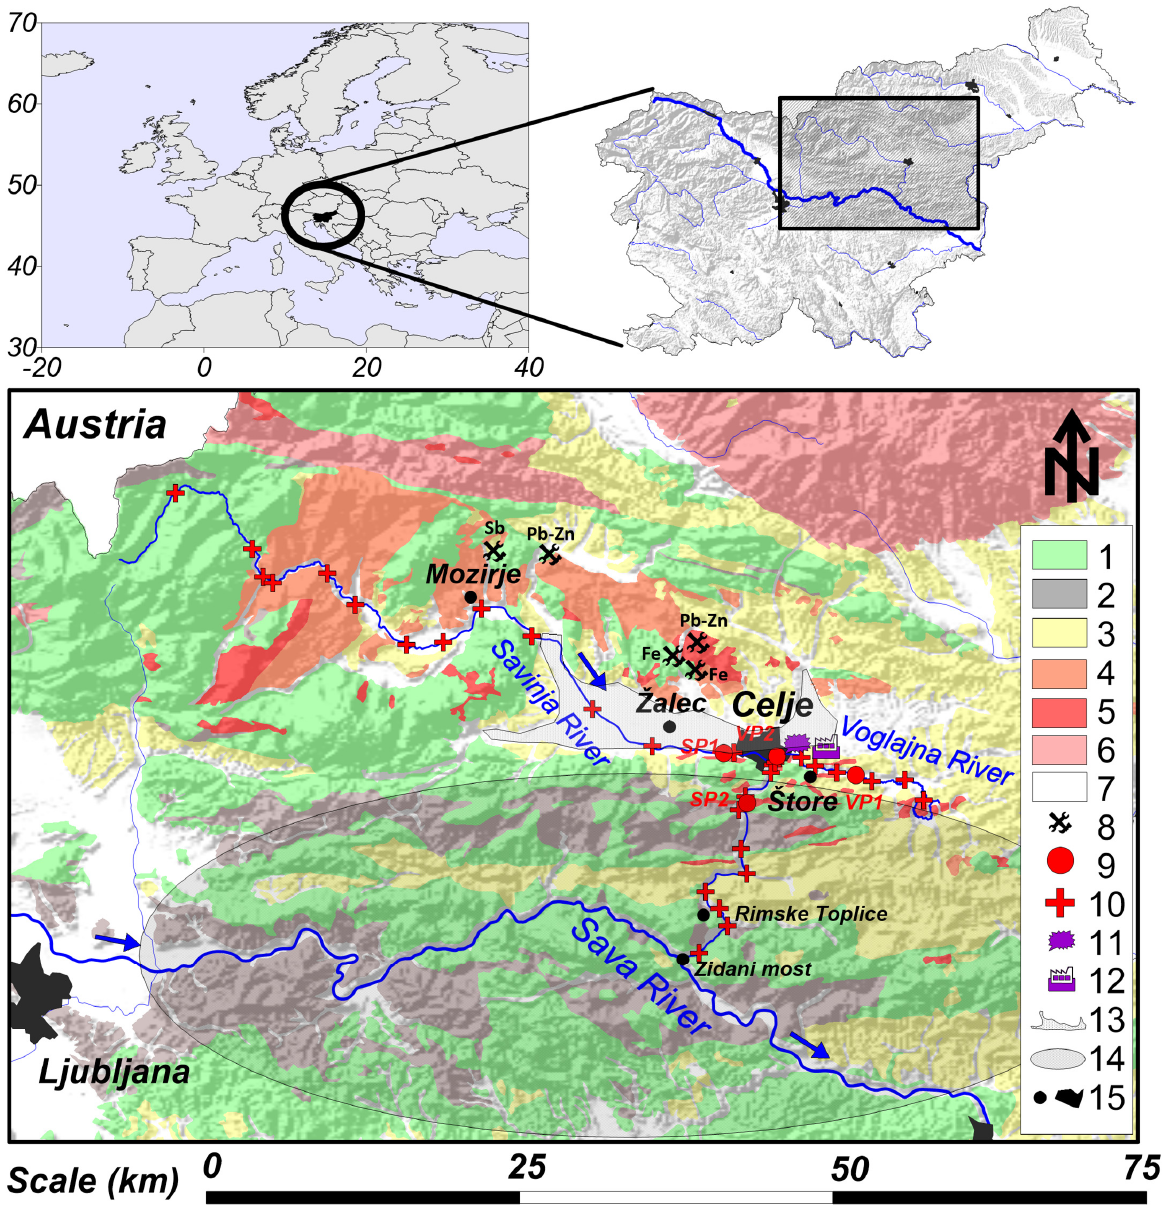
Figure 1. Simplified geological composition of the study area, sampling locations, populated areas, and major anthropogenic sources of elements. 1-mainly Mesozoic carbonates (limestone, dolomite); 2-Palaeozoic clastic rocks; 3-Paleogene and Neogene sedimentary clastic rocks (PG); 4-andesite tuffs and tuffites of Oligocene age; 5-Triassic keratophire intrusions; 6-other volcanic and igneous rocks (mainly felsic) various ages; 7-Palaeocene—Pleistocene sediments in basins; 8-small-scale metal mineralisation in the catchment area; 9-alluvial sediment sampling location (profiles), 10-stream sediments sampling locations, 11-pyrometallurgical waste deposit; 12-ironworks; 13-Celje basin; 14-Sava folds; 15-towns. Geological maps are simplified from